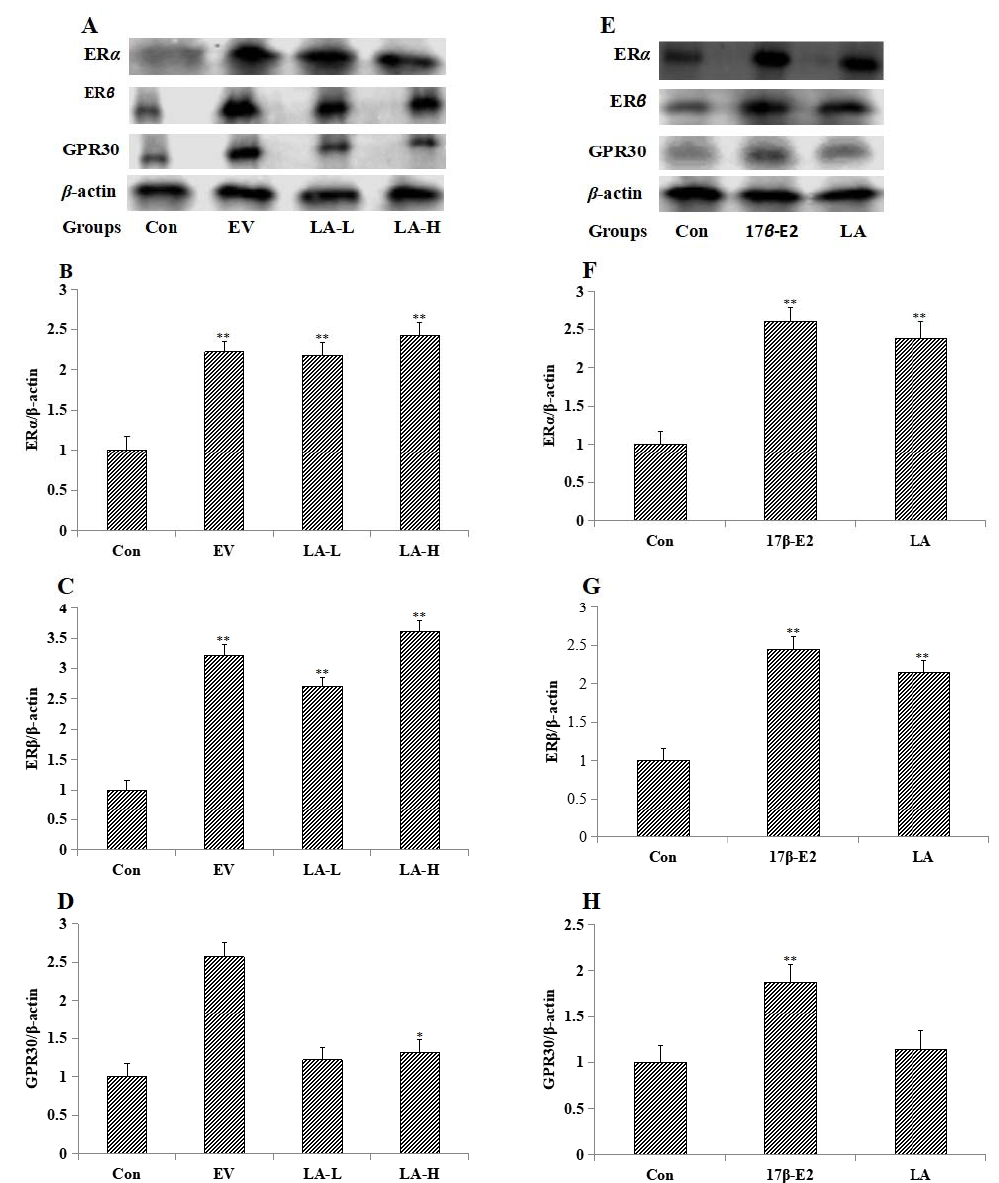
Figure 2. Western blot analysis of the expression of ER α , ER β and GPR30 in the uterus of immature female Swiss mice and MCF-7 cells ( n = 3). Figure ( A ), ( B ), ( C ) and ( D ) show the expression of ER α , ER β and GPR30 in the uterus. Figure ( E ), ( F ), ( G ) and ( H ) show the expression of ER α , ER β and GPR30 in MCF-7 cells. * p < 0.05; ** p < 0.01 compared to controls.